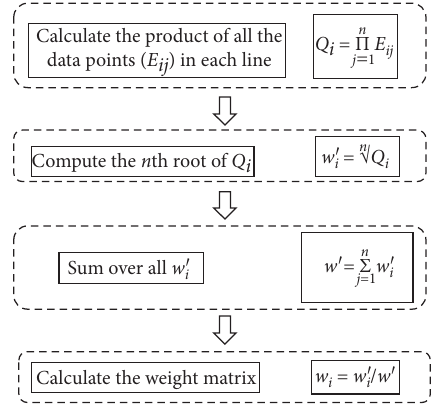
Figure 4: Steps to calculate weight values of indicators. Table 20: The weights of the evaluation